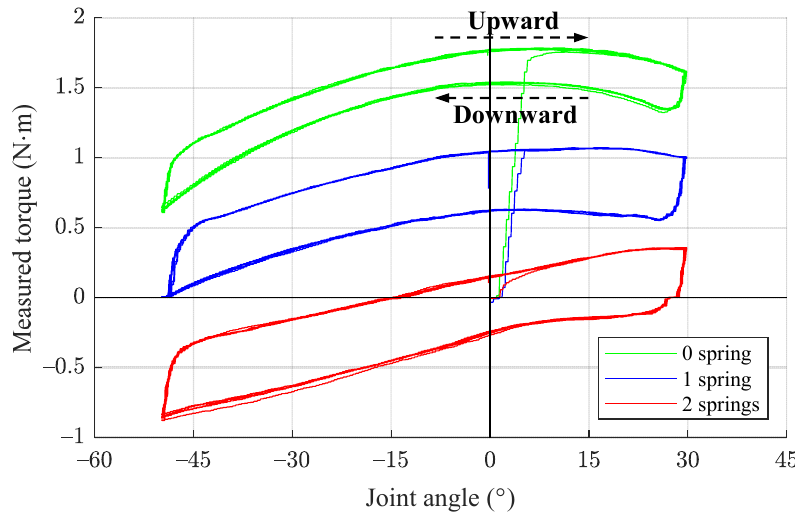
Figure 12. Measured torque according to the joint angle change for 5 times repetition between − 50° and 30°.